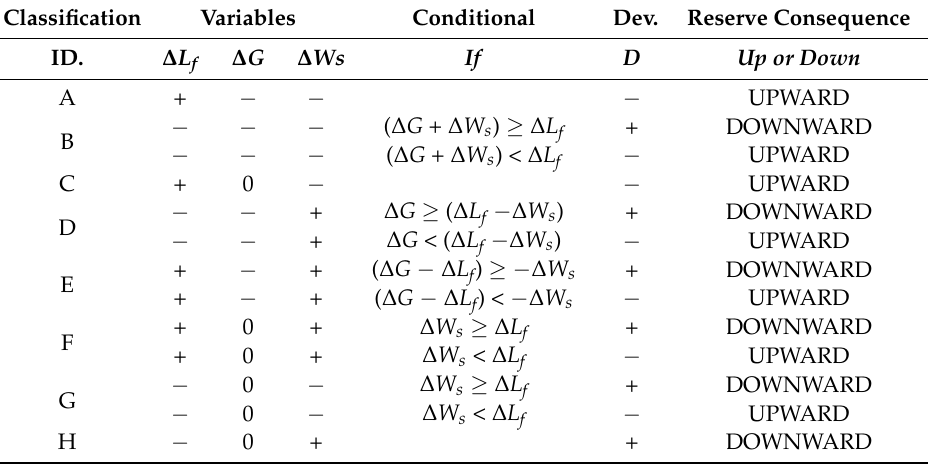
Table 3. System uncertainties impact on operating